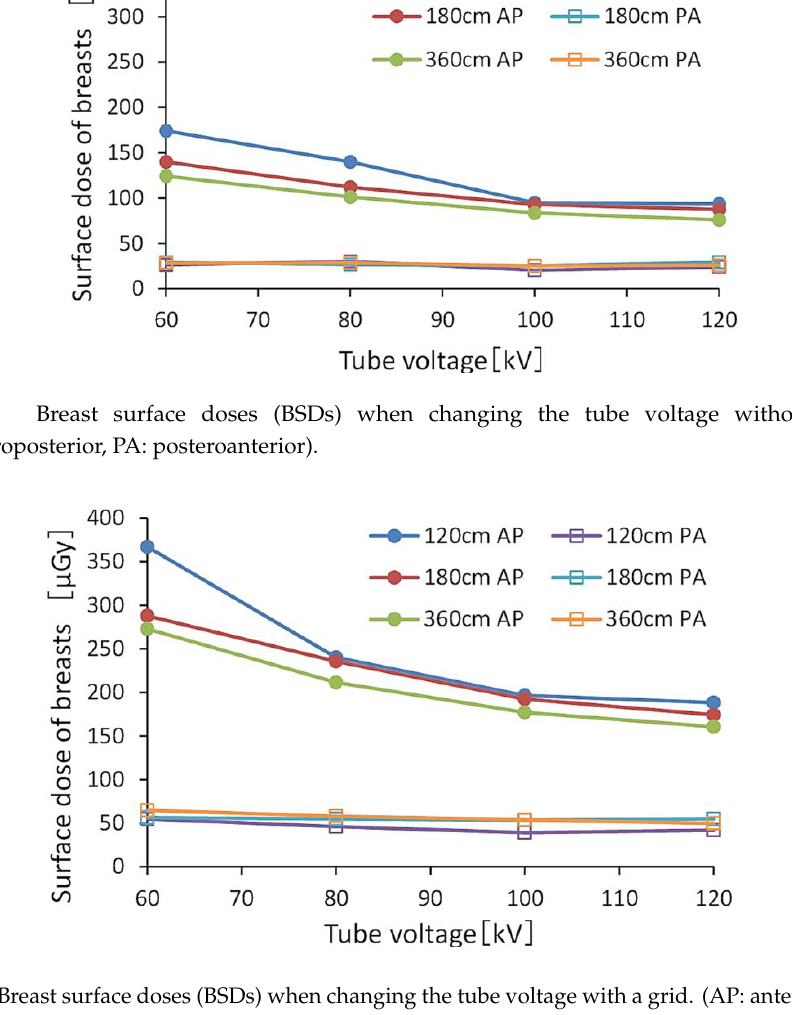
Table 3. The relative values of breast surface doses (BSDs) in the anteroposterior view (normalized at 60 kV).